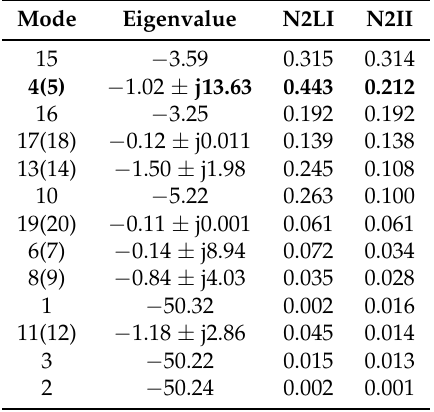
Table 2. 2nd-order NF indices for modal